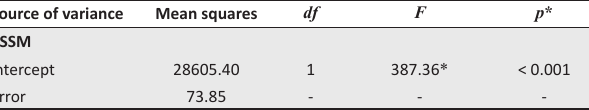
TABLE 1: Repeated analysis of variance for the psychological sense of school membership. Source of variance